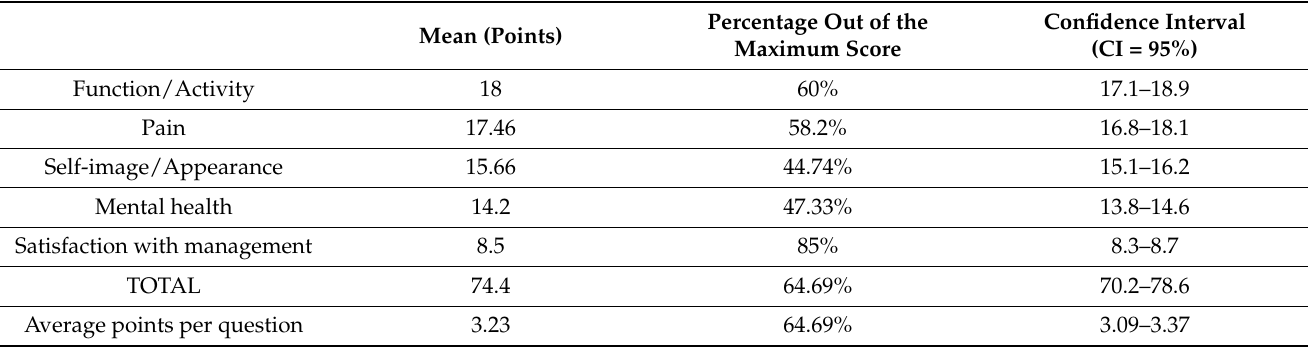
Table 1. The mean score, percentage of the maximum score, and confidence interval of Scoliosis Research Society 3 (SRS-30) and its domains before the surgery.